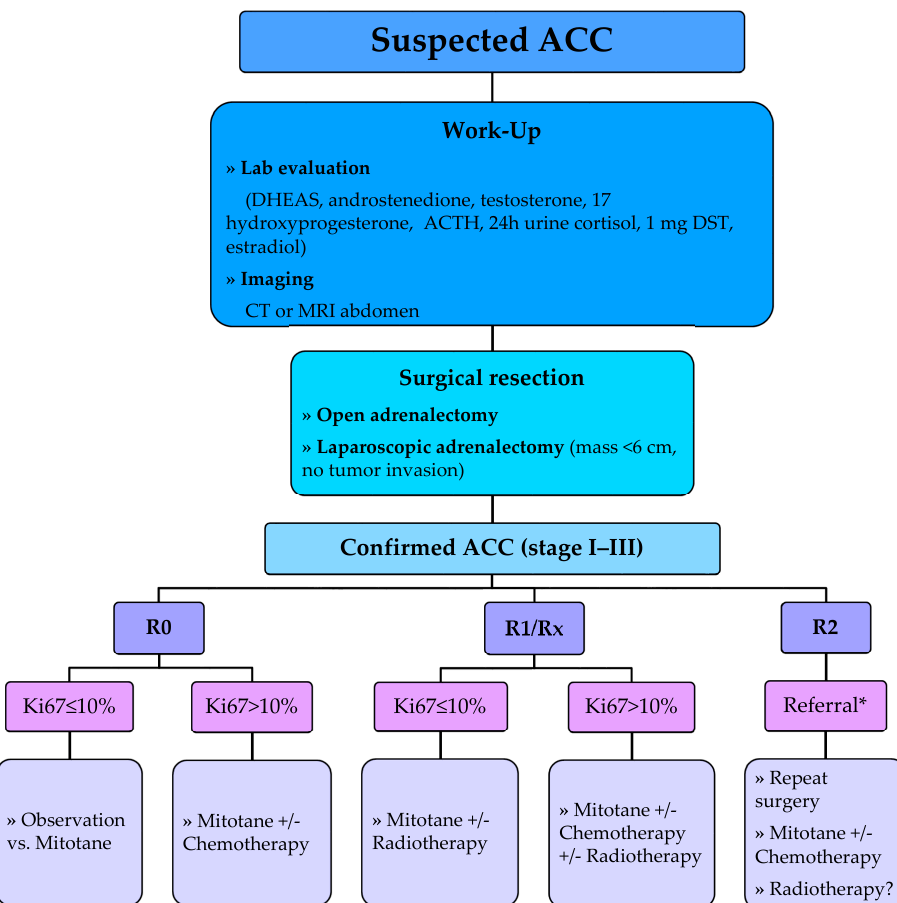
Figure 1. Suggested algorithm of the management of localized adrenocortical carcinoma. DST, dexamethasone suppression test; R0, no evidence of tumor; R1, microscopic evidence of tumor; R2, macroscopic residual disease; RX, margins unknown. * If initial surgery was done outside major referral